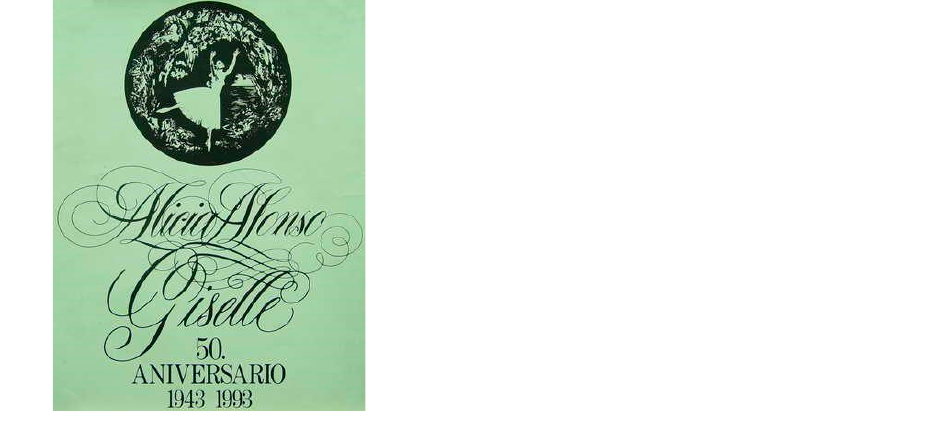
Figure 4. Poster for the 50th anniversary of Alicia Alonso’s debut as Giselle. 1993. [image is used from the official Website of the National Library José Martí, https://bnjm.cu/ (accessed on 12 April